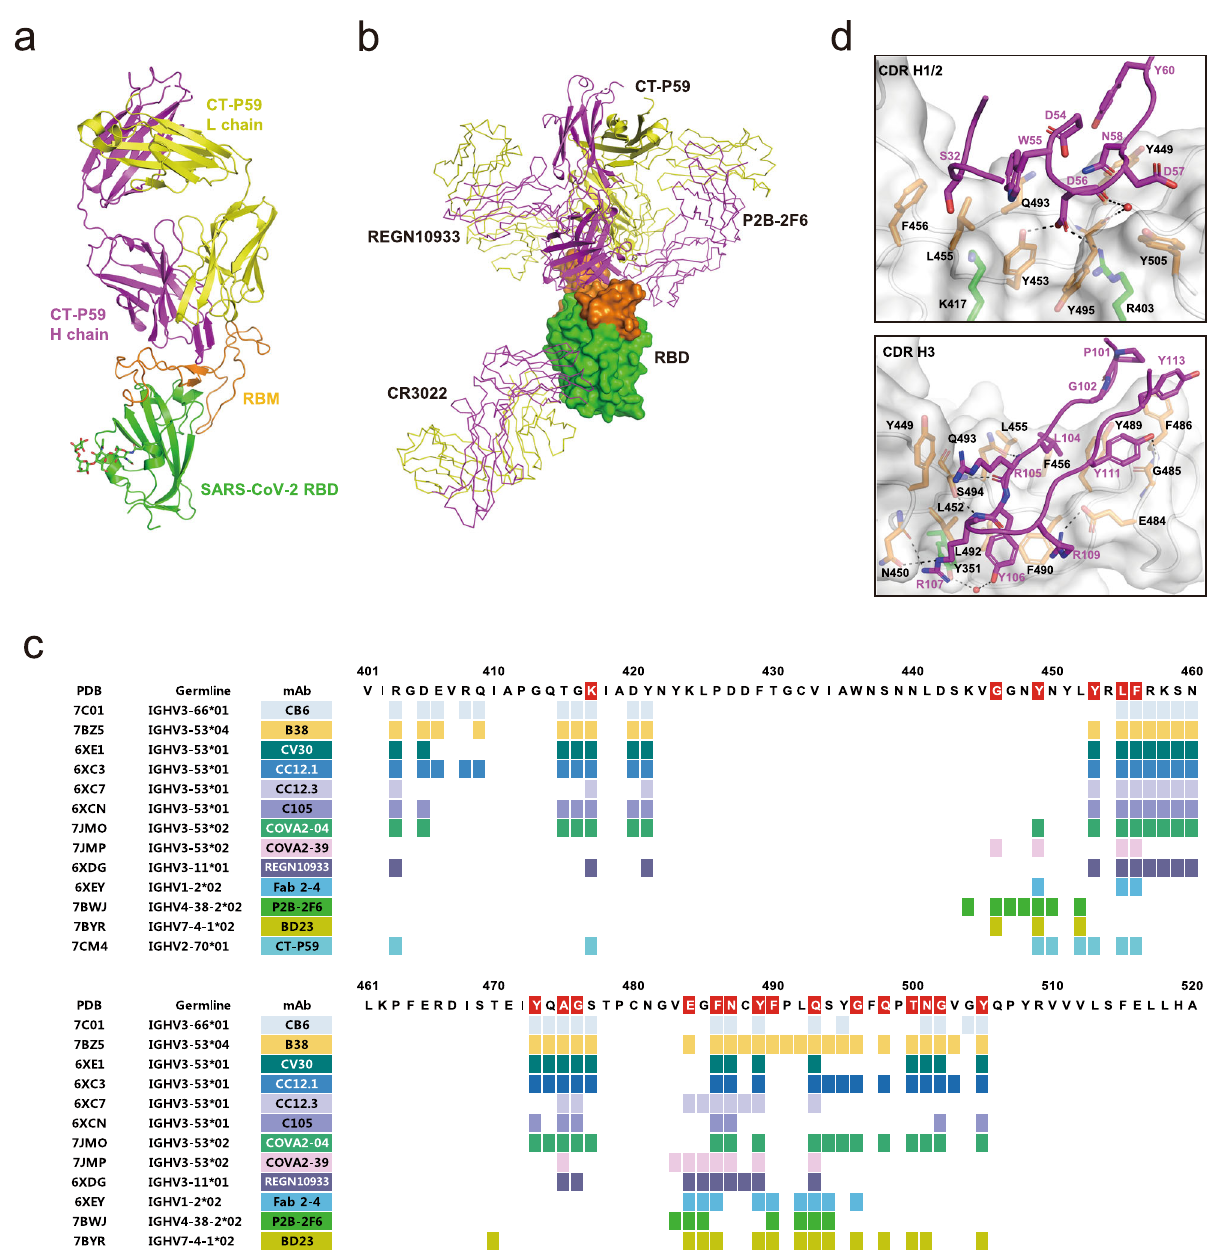
Fig. 2 The structure of CT-P59 Fab in complex with SARS-CoV-2 RBD. a The overall structure of the CT-P59 Fab/SARS-CoV-2 RBD complex. The RBD domain is green for the core subdomain, and orange for RBM. The heavy and light chains of CT-P59 are magenta and yellow, respectively. b Superposition of the neutralizing antibodies in complex with RBD. RBD is shown as a surface model. CT-P59 is shown as a cartoon, and the other antibodies (CR3022: PDB 6XC3, PB2-2F6: PDB 7BWJ, REGN10933: PDB 6XDG) are shown as a ribbon model. The heavy and light chains of Fab are magenta and yellow, respectively. c Assignment of the epitope residues for RBD-targeting neutralizing antibodies with a distance cutoff of 4.5 Å. RBD residues interacting with ACE2 are highlighted in red. d The detailed interactions between the RBD and CDR loops of CT-P59. The interfaces between RBD and CDR H1/2 or H3 are shown in the top and bottom panels, respectively. The RBD domain is shown as a surface model with a semi-transparent representation. The CDR loops and interacting residues on the interfaces are shown in ribbons and sticks, respectively. The residues are colored as in a . Dashed lines indicate hydrogen bonds. Water molecules are shown as red